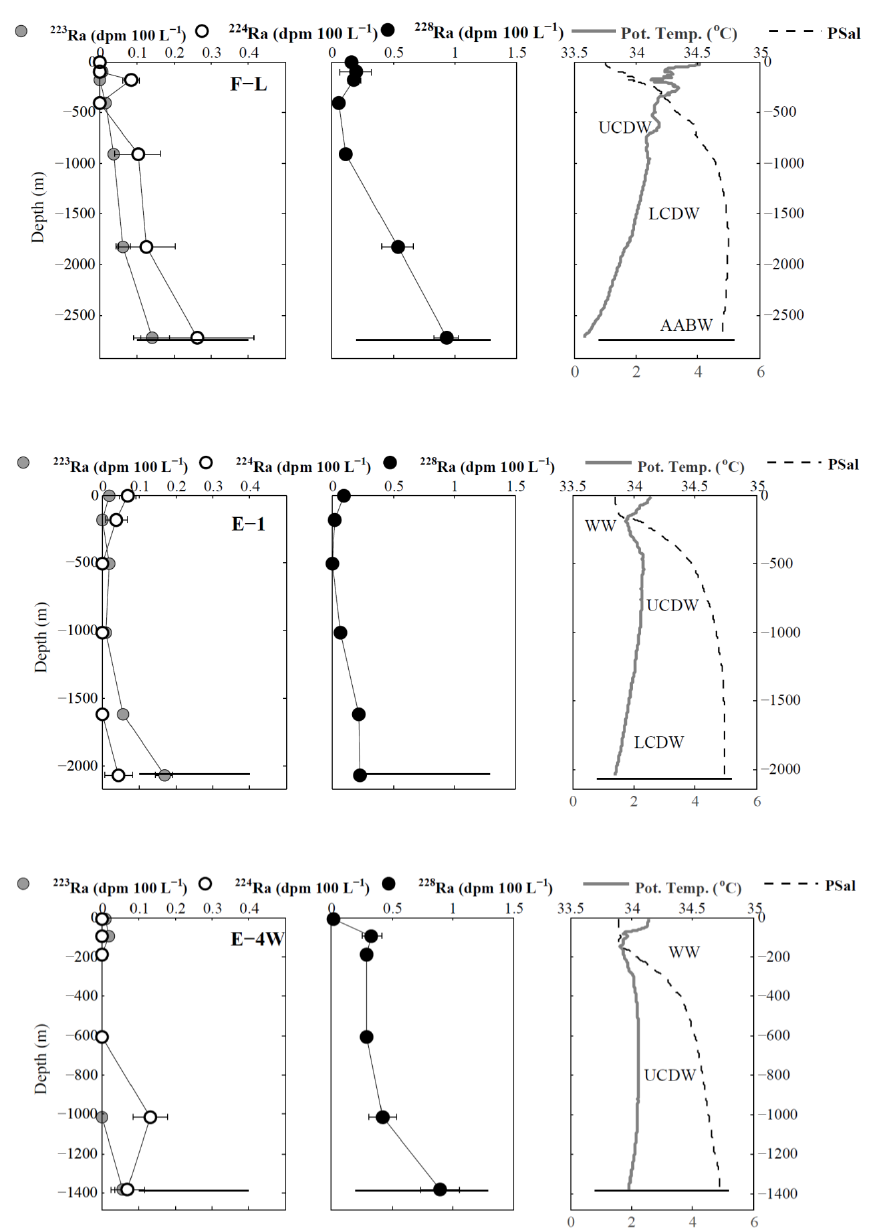
Figure 6. 223 Ra, 224 Ra and 228 Ra activities (dpm100L − 1 ) at the deep stations. The major water masses are indicated: Winter Water (WW), Upper Circumpolar Deep Water (UCDW), Lower Circumpolar Deep Water (LCDW) and Antarctic Bottom Water (AABW). The bottom depth is denoted by the horizontal